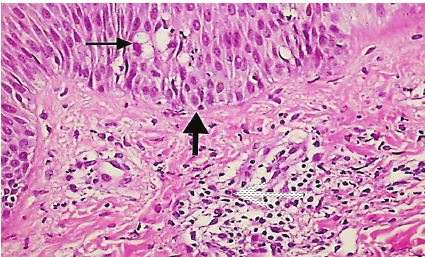
Figure 3: A photomicrograph of the biopsy showing neutrophilic pustular lesion together with epidermal spongiosis (thin arrow), minimal irregular acanthosis in epidermis (thick arrow), and neu- trophilicandeosinophilicinfiltrationarounddermalvessels(dashed arrow) (H&E ×